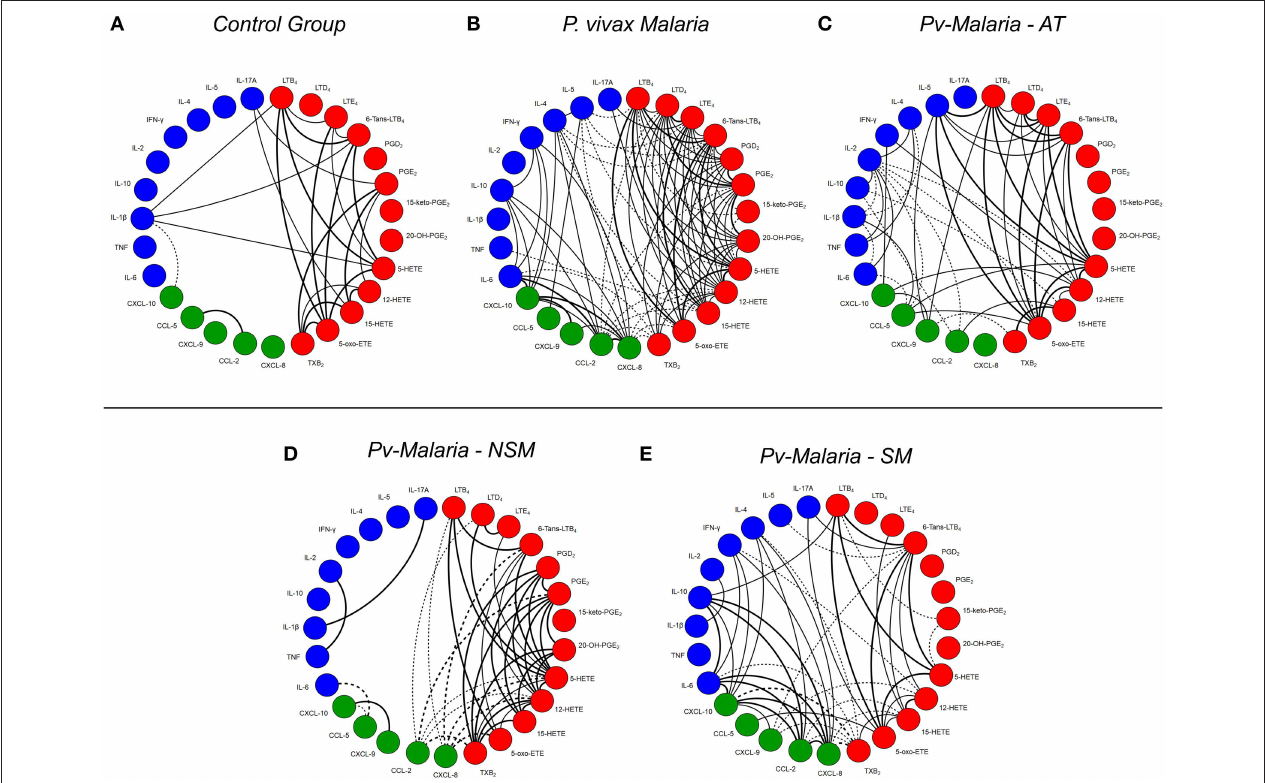
FIGURE 4 | A network of interaction between eicosanoids, chemokines and cytokines in control group, Pv -malaria patients, individuals who returned 28 days after treatment, understood as the period of convalescence and Pv -malaria patients at the time of diagnosis who did not Self-Medication (NSM) and Self-Medicated (SM). Each connecting line is a significant correlation between a pair of markers. Continuous lines represent positive correlations, while dashed lines represent negative correlations ( p < 0.05). The degree of significance is represented by the thickness of the line. Correlations were obtained through the Spearman test; the value of r and p were used to classify the connections as weak ( r ≤ 0.35, p < 0.05), moderate ( r = 0.36–0.67, p < 0.01) or strong ( r ≥ 0.68, p < 0.0001). The absence of the line indicates the non-existence of the